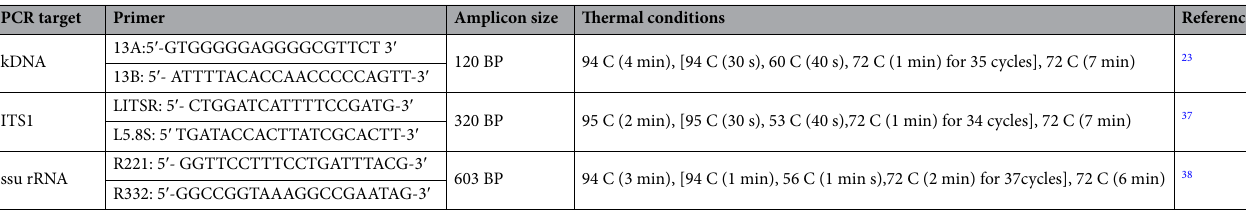
Table 1. PCR targets, primers, amplicon size and thermal cyclic conditions of the study PCR